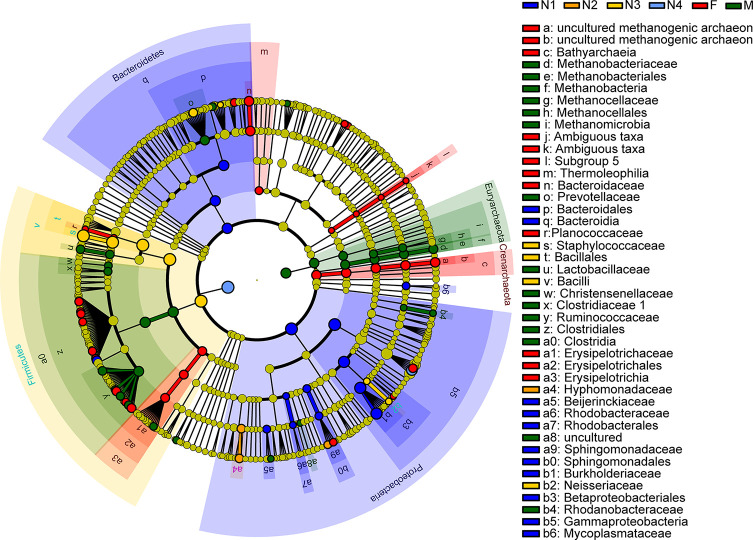
Cladogram showing discriminated taxa at different ages of T. rubrofasciata (N1, 1st stage nymphs; N2, 2nd stage nymphs; N3, 3rd stage nymphs; N4, 4th stage nymphs; N5, 5th stage nymphs; F, female adult; M, male adult). Regions with different colors represent different groups. Different colored nodes in the branches represent the microbial groups that play an important role in the corresponding groups, whereas yellow nodes indicate bacterial groups that are nonsignificant in all groups.